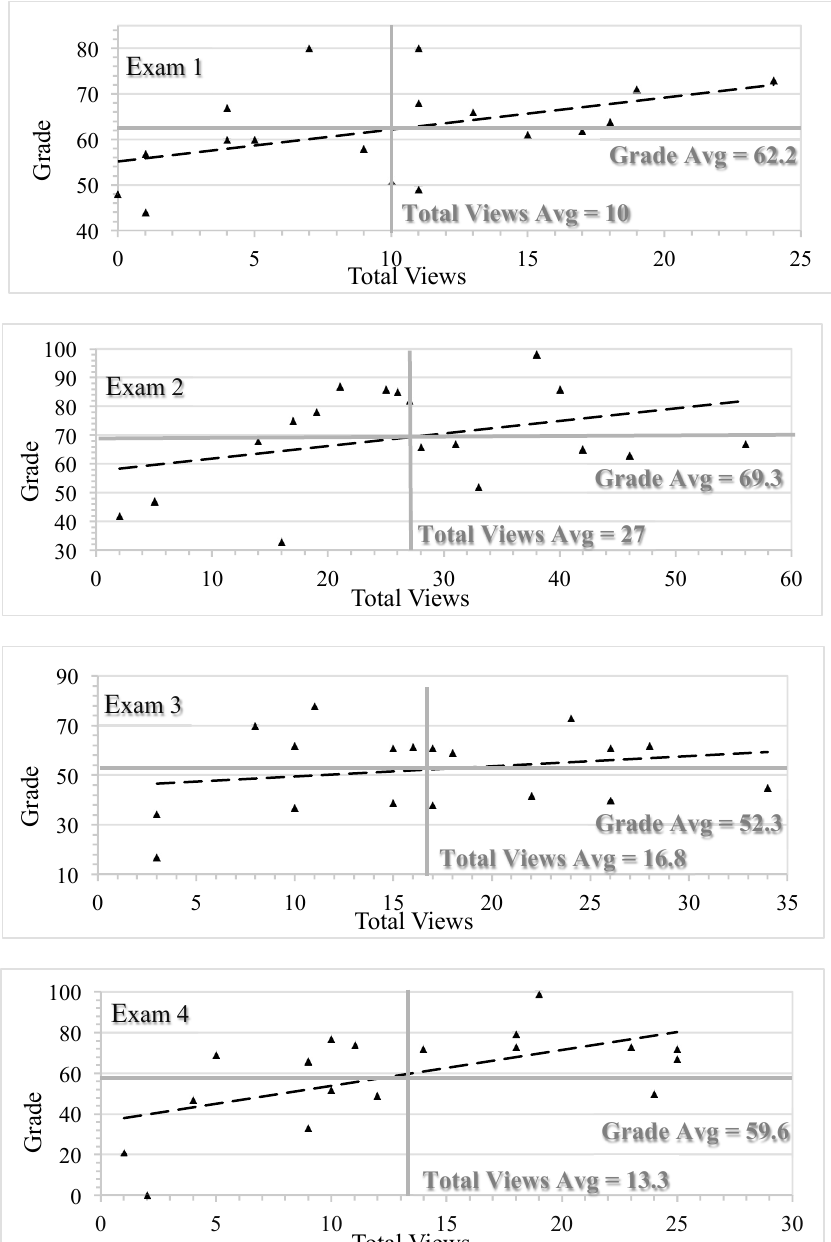
Fig 3. Exams 1-4 Student grades with student Total Views with quadrants separated by average exam grade and average exam views (grey horizontal lines are the average exam grade and vertical lines are average total